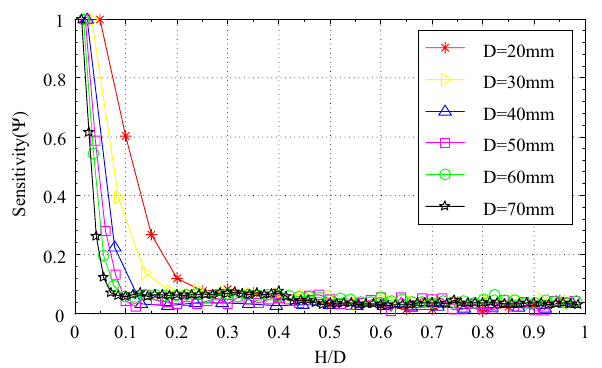
Fig. 8 Sensitivity distribution curves of MCP values at z = 0: h = 2 mm, d = 1.5 mm and S = 4